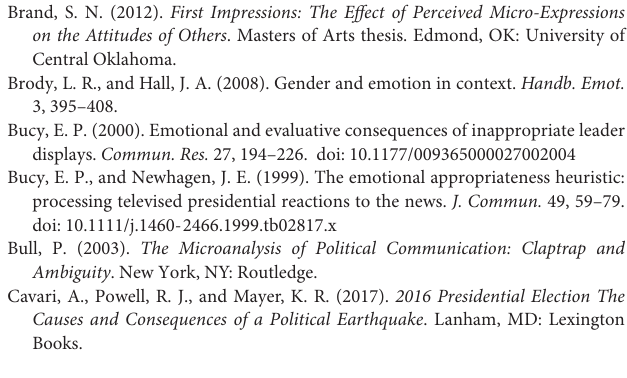
Supplementary Figure 1 | Donald Trump’s first micro-expression with lip corners stretching and lips parting ( 20C [frames 1029-1046] + 25B [frames 1025-1046]